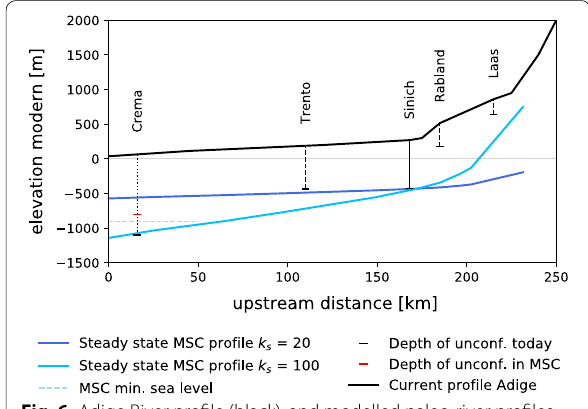
Fig. 6 Adige River profile (black), and modelled paleo-river profiles with different properties (blue). Valley bedrock depths from drill wells and seismic interpretations are in black (continuous drilled; = dashed partially drilled; dotted seismic depth). The red depth = = corrects subsidence in the Po Plain and restores the paleo-elevation of the incision. The modelled river profiles are set so that they intersect today’s depth at Sinich, which is equivalent to assuming no uplift or subsidence since the incision event at Sinich